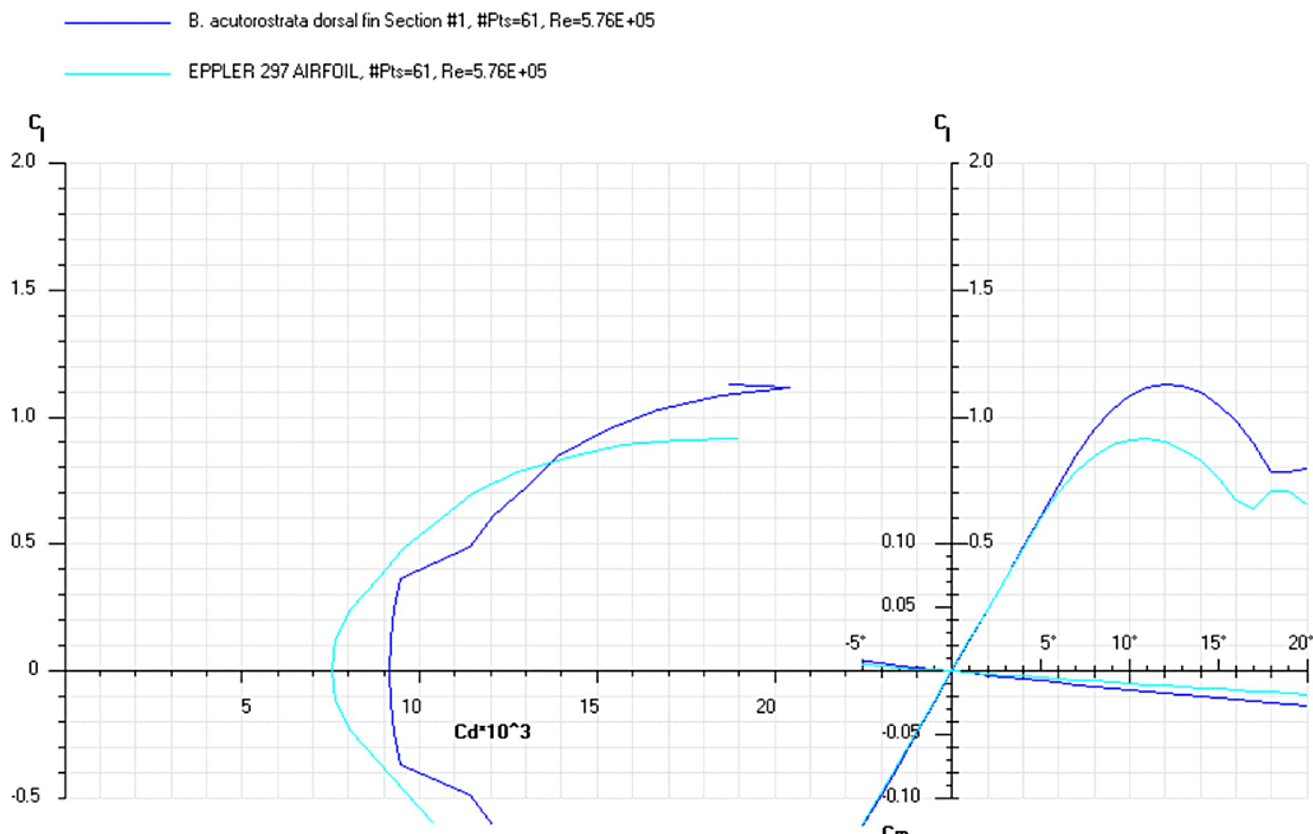
Fig 14. Drag polar diagram of lift CL vs drag Cd. Calculated for the cross-sections taken at the base of the dorsal fin of the B . acutorostrata and Eppler 297 airfoil at the averaged Re 5.76E+05 for the fin cross-sections (Table